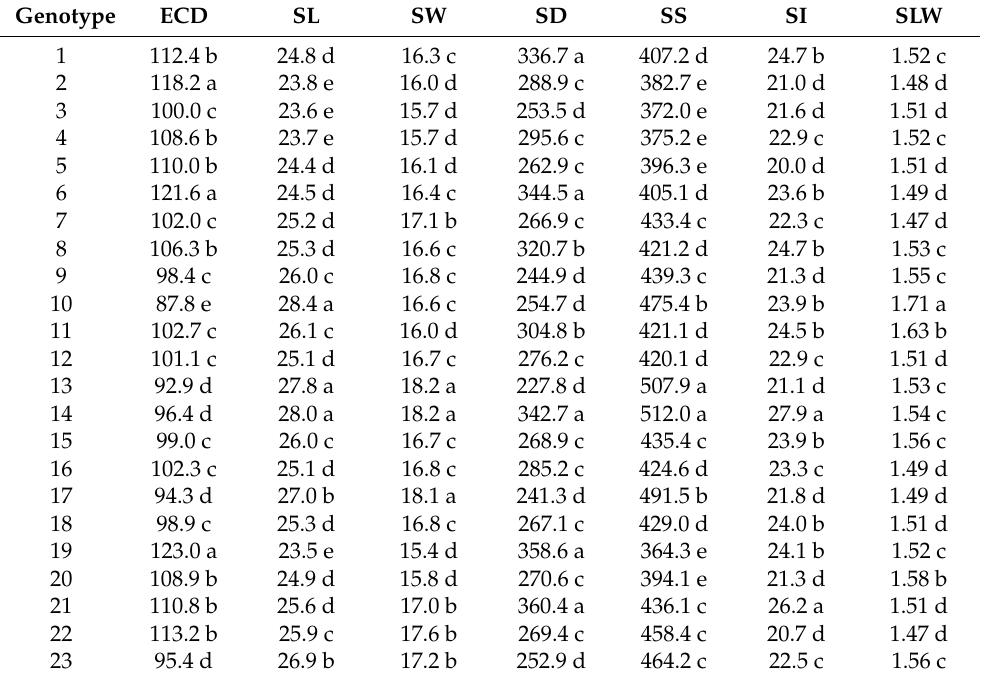
(Table 3). The Scott–Knott tests allowed the detection of variability between genotypes for all leaf morpho-anatomical traits, assembling the genotypes in up to six groups (Table 3). Table 3. Mean values for the leaf morpho-anatomical traits evaluated in 43 genotypes of Coffea canephora . The different letters indicate significant differences the genotypes according to the Scott– Knott